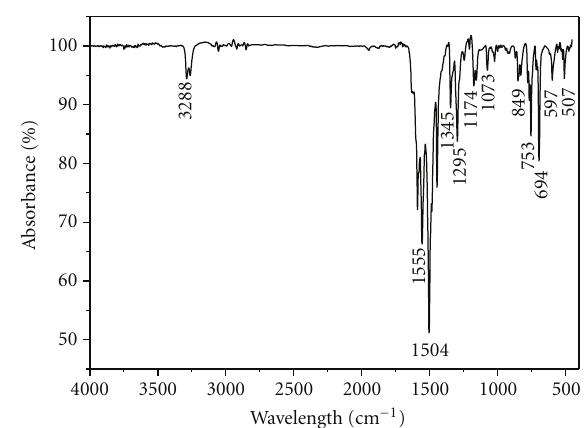
Figure 1: FT-IR spectra of the reduced polymer (PANI-EB) pre- pared at 25 ◦ C.